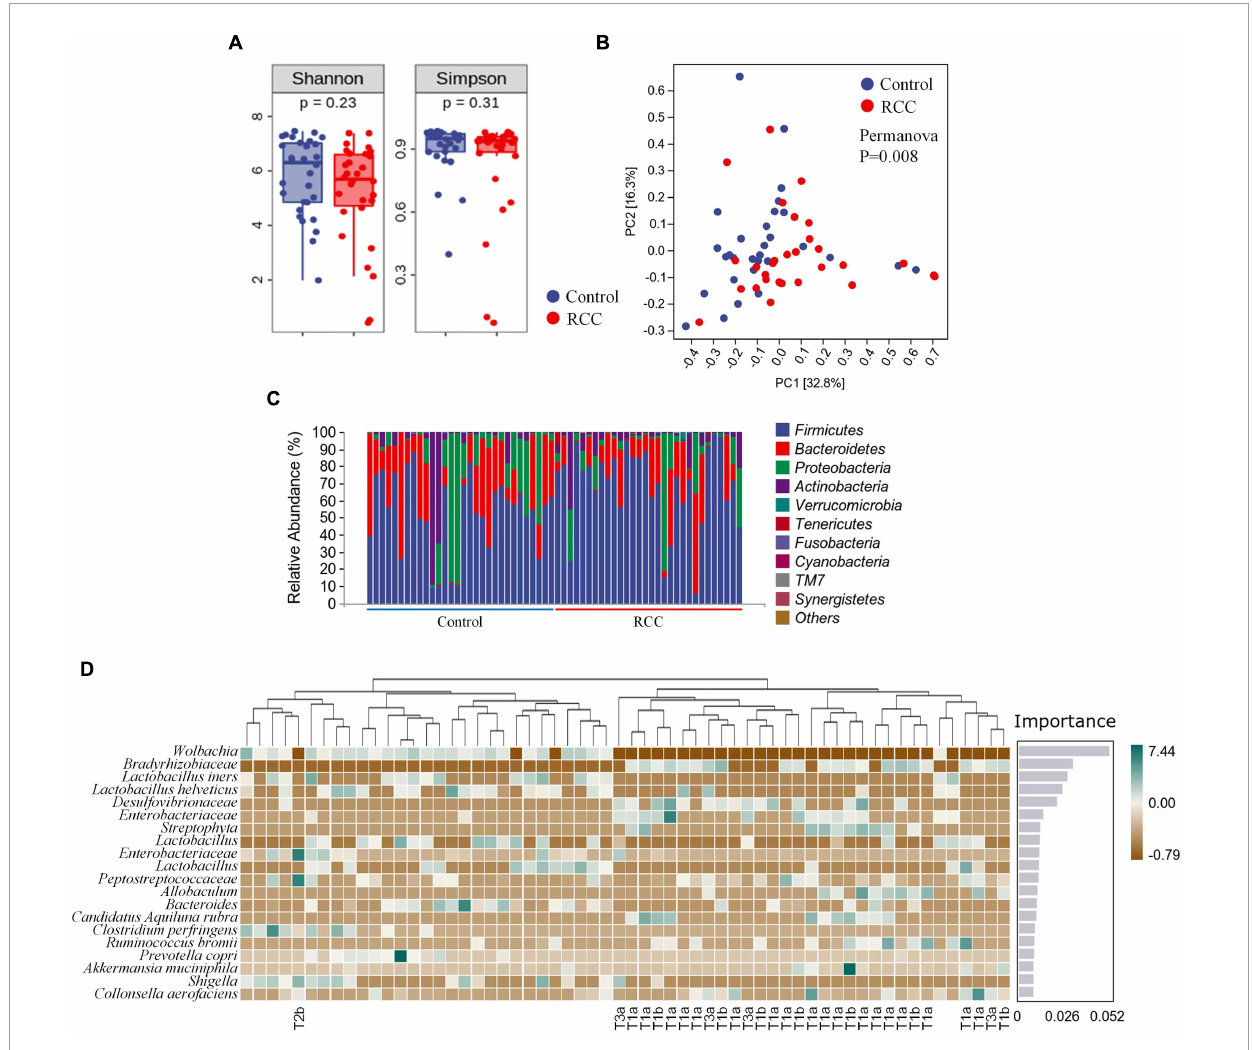
FIGURE1 Characterization of gut microbiota were identified in the RCC and Control groups. (A) Alpha diversity of gut microbiota. The within-sample diversity of the RCC group and Control group were measured in terms of Shannon index and Simpson index. (B) Assessment of overall gut microbiota structures between the two groups using PERMANOVA analysis. PC1, principal coordinate 1; PC2, principal coordinate 2. (C) Relative abundance of gut microbiota in the two groups at phyla level. (D) Altered 20 genera significantly in the RCC group (marked with pathological grade) compared to Control group arranged based on the potential importance by Random Forest analysis. Green indicates positive correlation; brown indicates negative correlation. Non-significant P > 0.05.